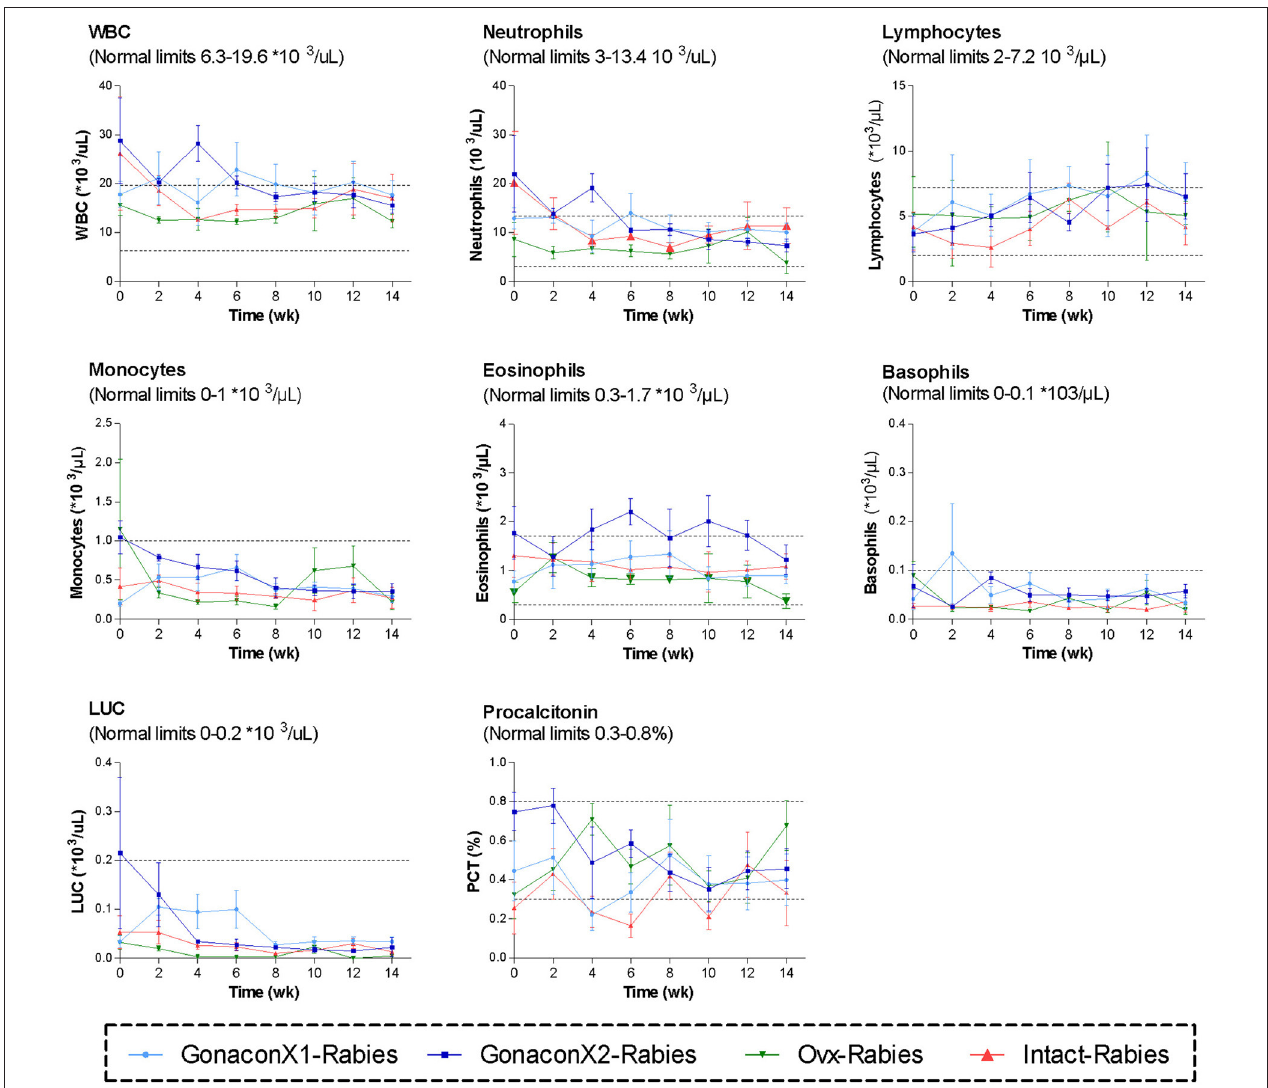
FIGURE 3 | White blood cells parameters of cats in the research groups. Mean ± SEM of white blood cells parameters are presented for each group: GonaconX1-Rabies: cats vaccinated with both Gonacon and rabies ( n = 5); GonaconX2-Rabies: cats vaccinated twice with Gonacon (3 weeks apart) and with rabies ( n = 4); OVx-Rabies: cats ovariohysterectomized and vaccinated with rabies ( n = 4); Intact-Rabies: cats vaccinated against rabies and remained intact ( n = 3). Blood samples were collected every 2 weeks for a total of 14 weeks. Dotted lines indicate normal limits. WBC, white blood cells count; LUC, large unstained